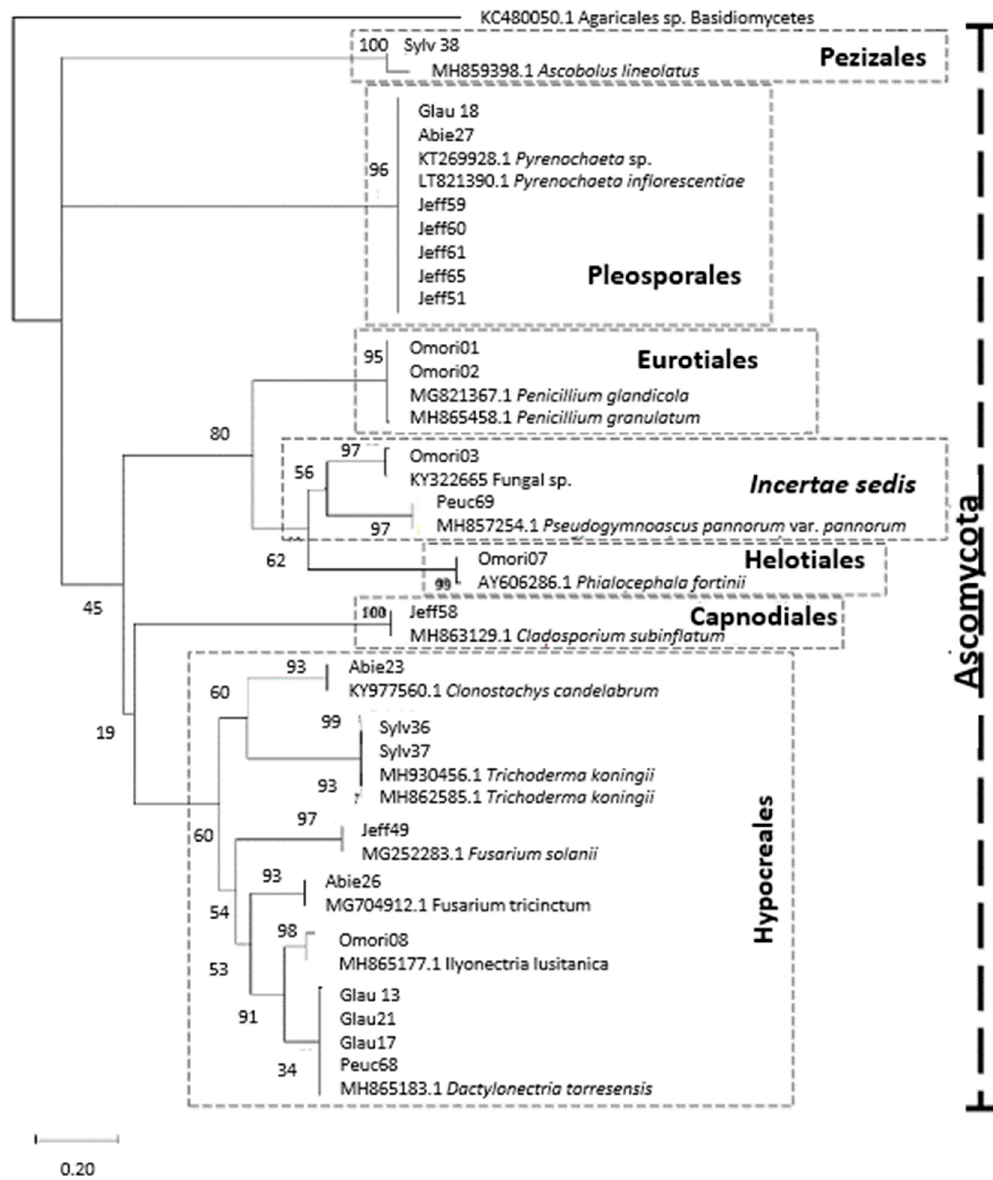
Figure 4. Molecular phylogenetic analysis by maximum likelihood (ML) based on concatenated ITS sequences. The percentage of replicate trees in which the associated taxa clustered together in the bootstrap test are shown next to the branches. Also indicated are the orders to which the samples belong to (dashed rectangles w/ descriptions), the phylum (dashed vertical bar), and the outgroup taxon (the Basidiomycete KC480050.1 Agaricales sp. isolated from P. abies by Terhonen et al. [19].